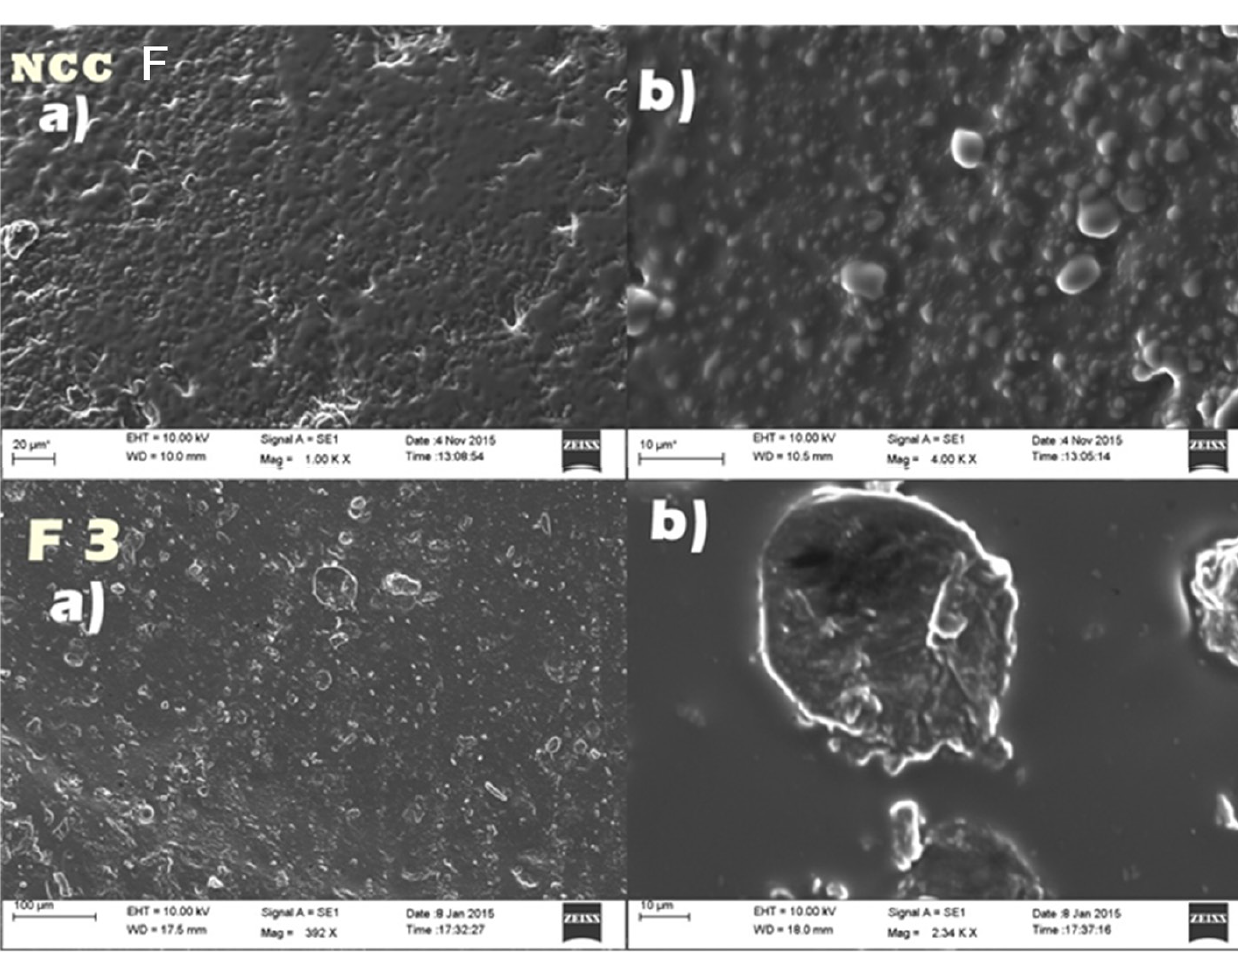
FIGURE 6 - SEM images (a) and its enlarged image (b) for NCC-F and F3 formulations.